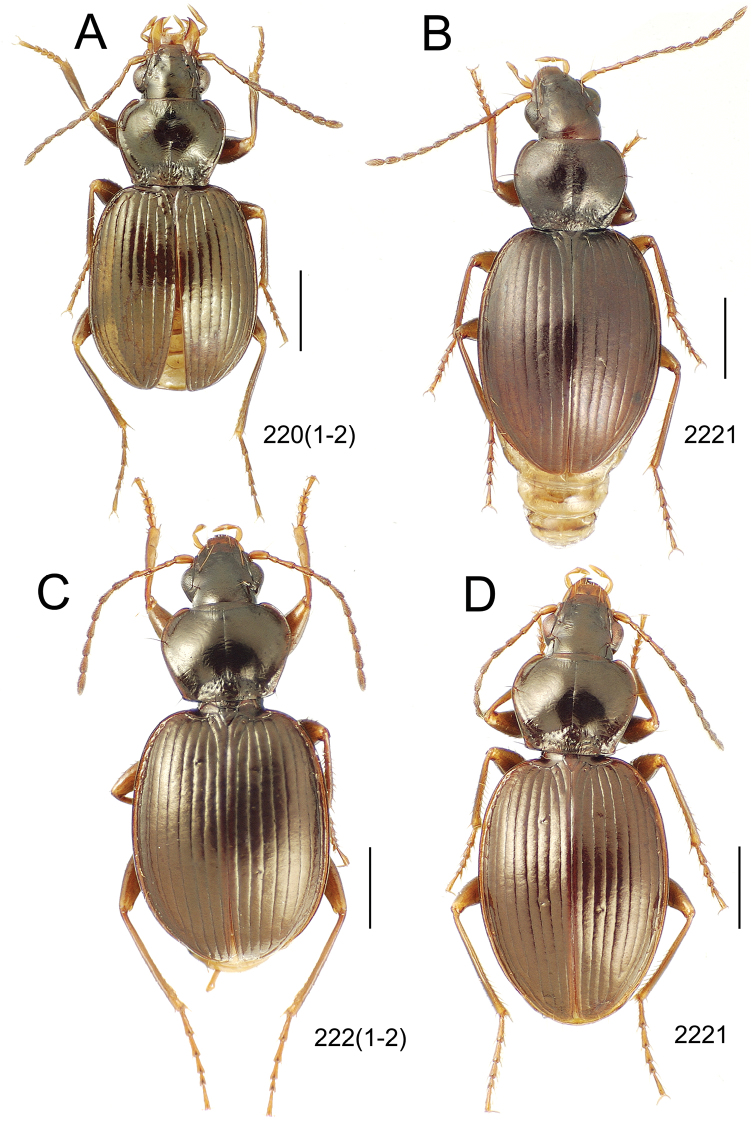
Mecyclothorax spp., dorsal view; scale bars 1.0 mm; setal formula (see Fig. 10) at lower right of each figure A
Mecyclothorax fairmairei holotype male B
Mecyclothorax tutei holotype female C
Mecyclothorax aorai
D
Mecyclothorax cooki